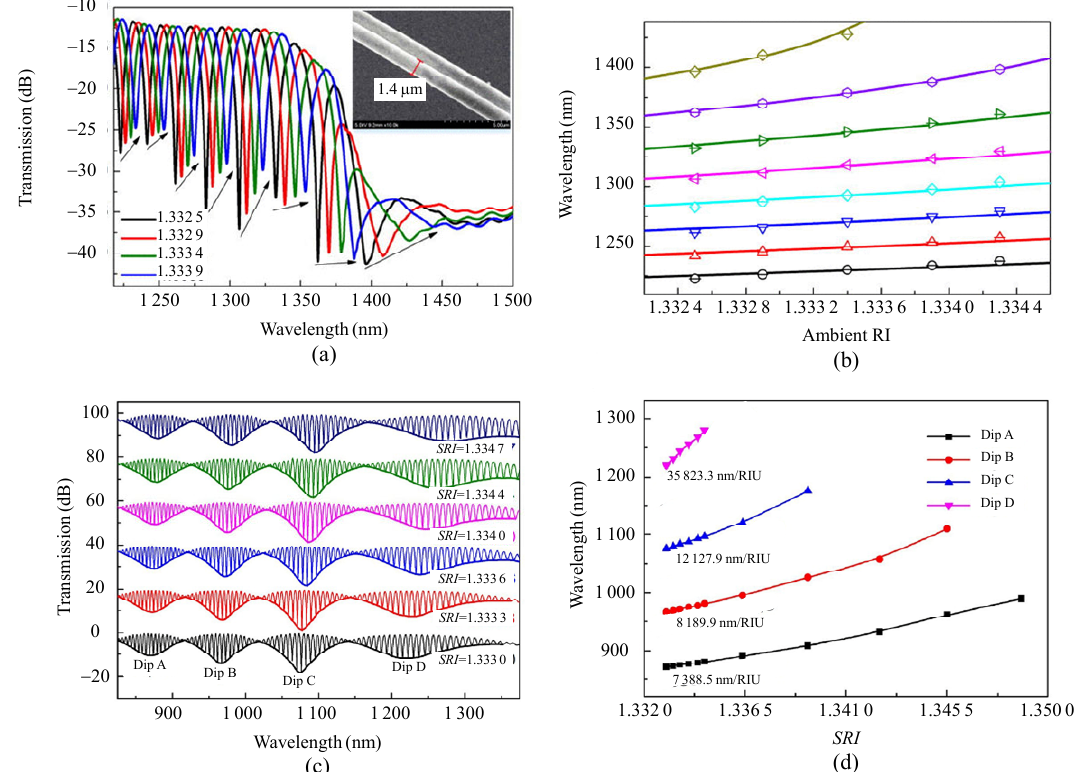
Fig. 9 Phase-based MFC sensors with ultrahigh sensitivities: (a) transmission spectral responses to different ambient RIs for an MFC sensor operating near the turning point of effective group index difference. Reproduced with permission [100]. Copyright 2016 AIP Publishing; (b) modeled (solid curves) and measured wavelengths (points) at transmission dips versus ambient RI for the MFC sensor operating near the turning point. Reproduced with permission [100]. Copyright 2016 AIP Publishing; (c) transmission spectra of an MFC sensor with the Vernier effect for different surrounding RIs (spectra are offset by 22 dB). Reproduced with permission [182]. Copyright 2018 Elsevier; (d) measured wavelengths at transmission dips versus surrounding RI for the MFC sensor with the Vernier effect. Reproduced with permission [182]. Copyright 2018 Elsevier.